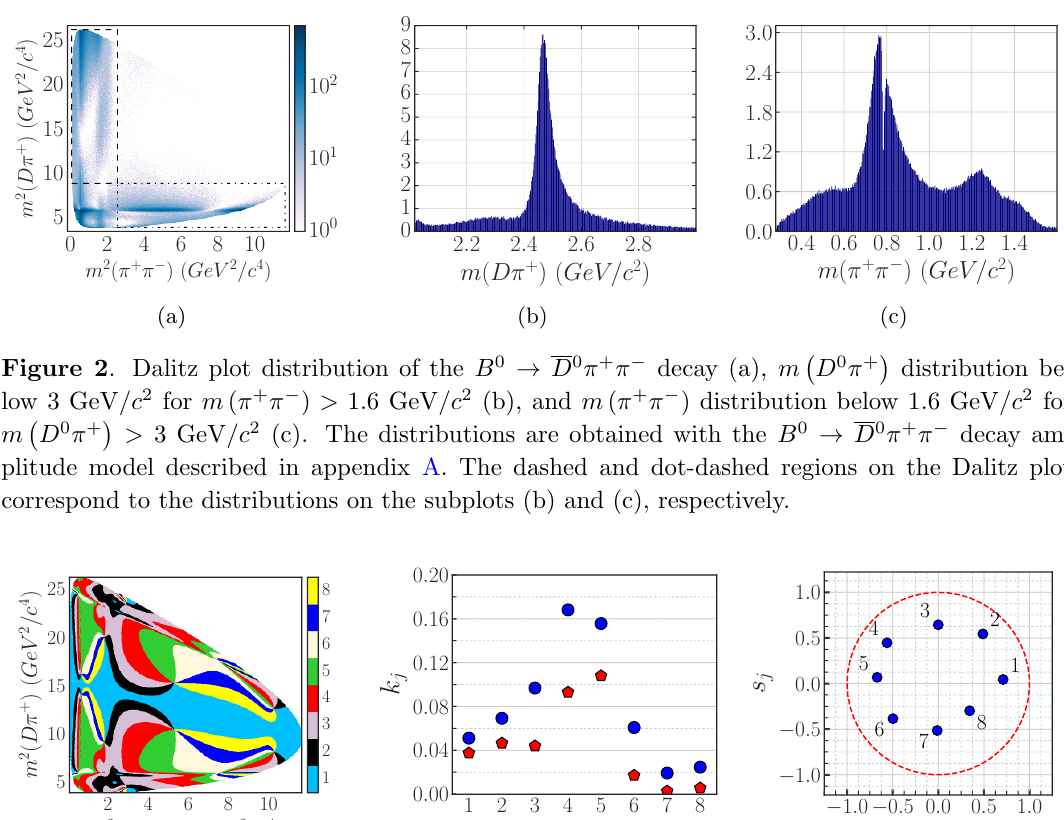
Figure 3 . Equal-phase Dalitz plot binning (a), values of the parameters k j for j > 0 (blue circles) and j < 0 (red pentagons) (b), and values of the parameters c j and s j (blue circles) (c) obtained with the B 0 D 0 (cid:25) + (cid:25) (cid:0) decay amplitude model described in appendix !